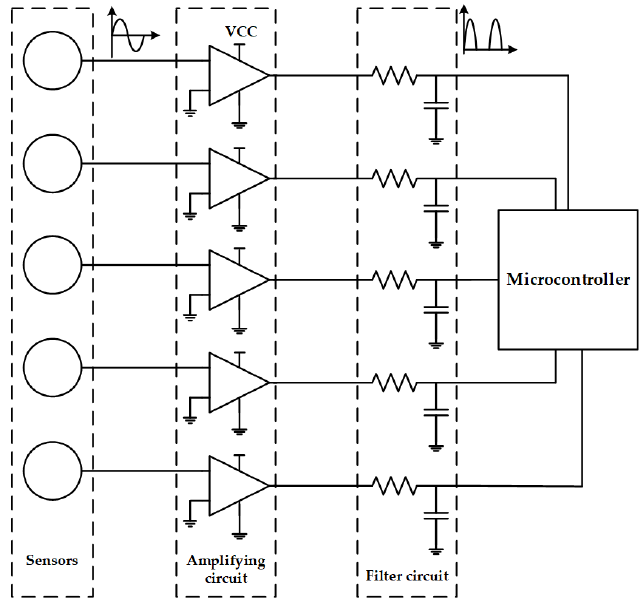
Figure 18. Hardware system schematic.